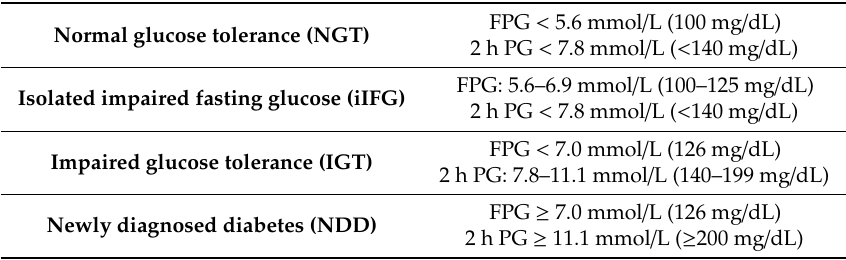
Table 4. Glycemic status